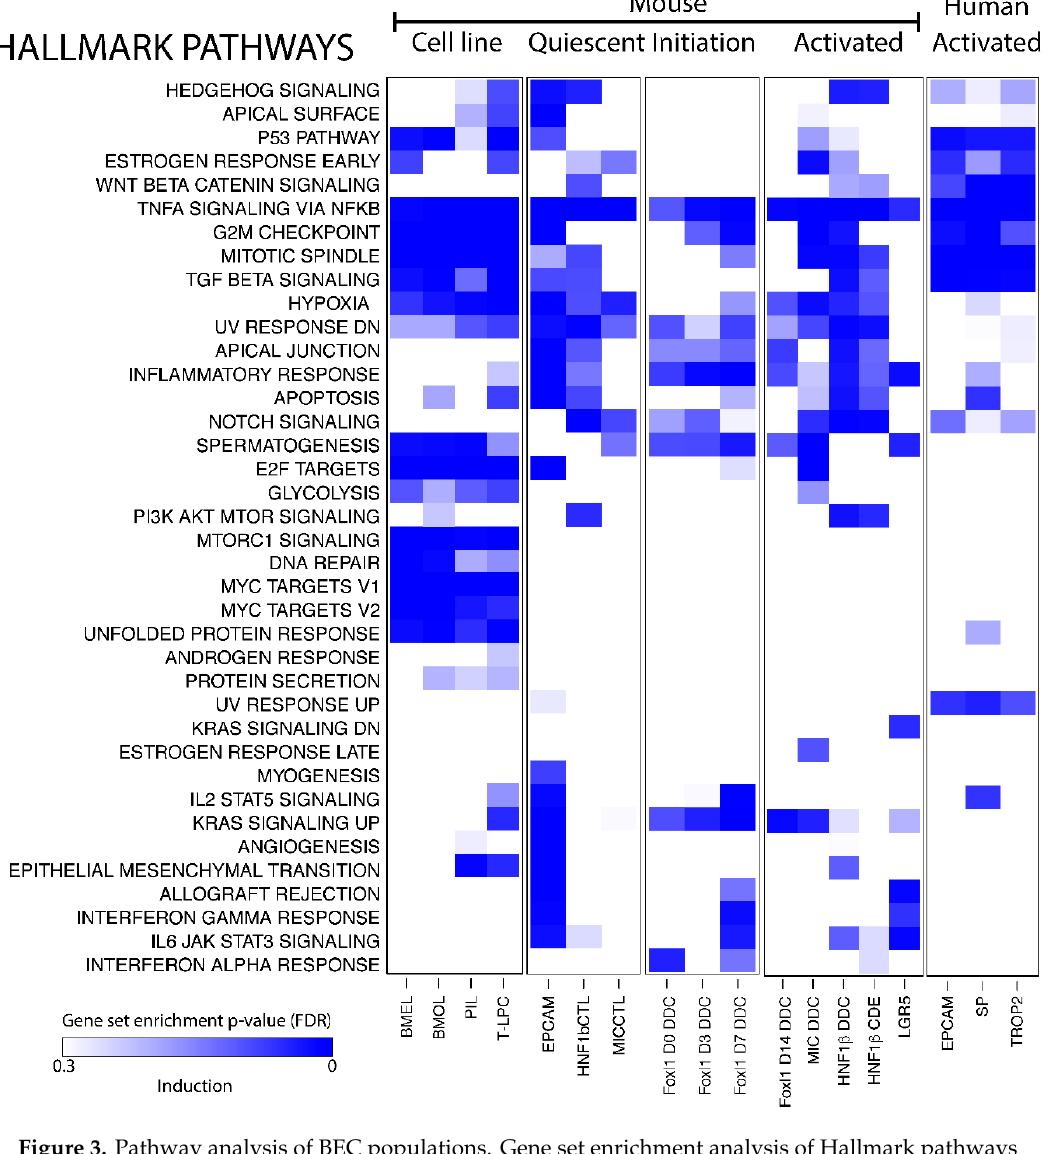
Figure 3. Pathway analysis of BEC populations. Gene set enrichment analysis of Hallmark pathways on transcriptomic profiles of BECs compared to healthy (mouse) or injured (human) livers. Gradient of the blue color represents positively enriched pathway (False discovery rate, FDR).